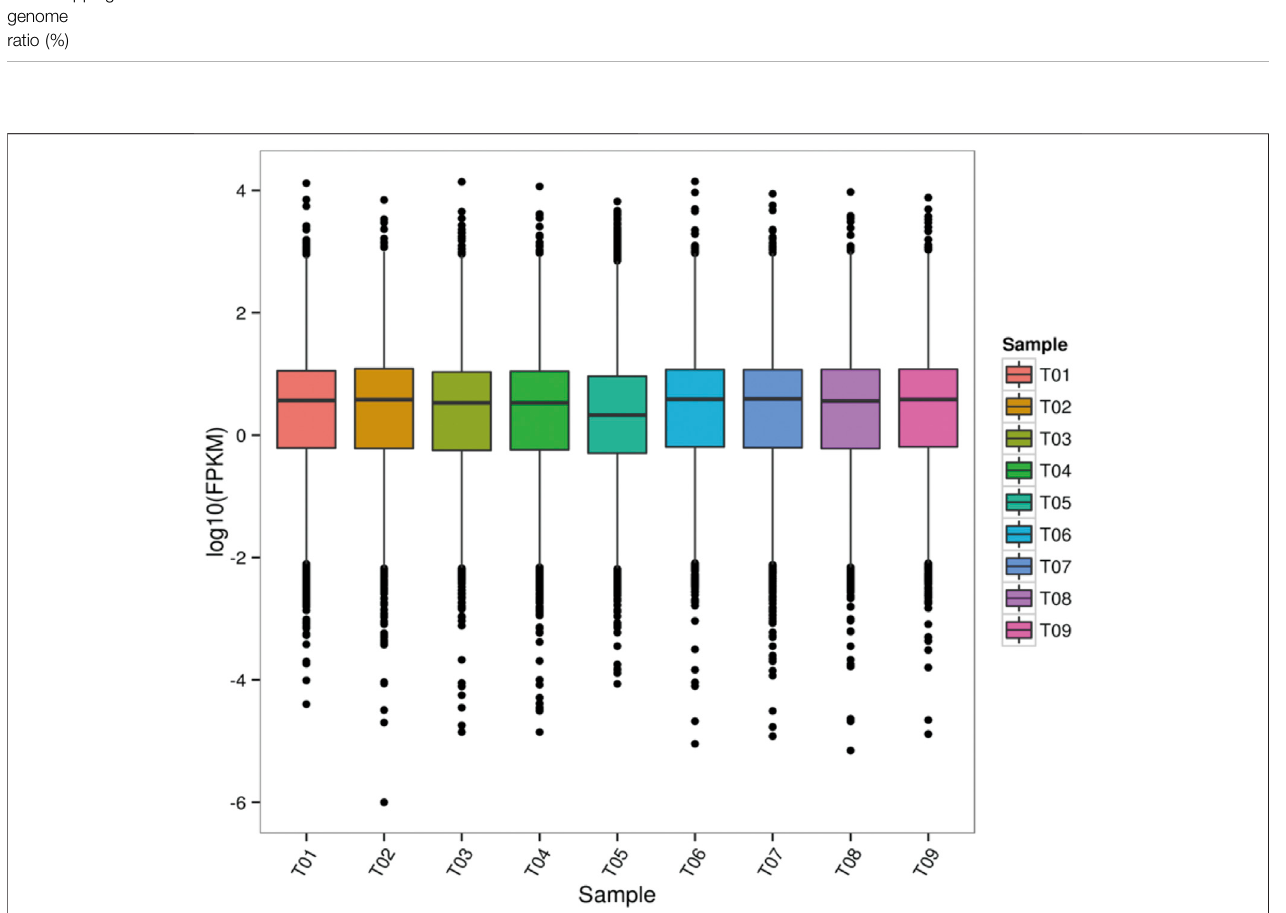
FIGURE2| FPKMbox linediagramfor eachsample.T01,T02, andT03weretheprepubertal groups.T04, T05,and T06were thepubertal groups. T07,T08,and T09 were the postpubertal groups.